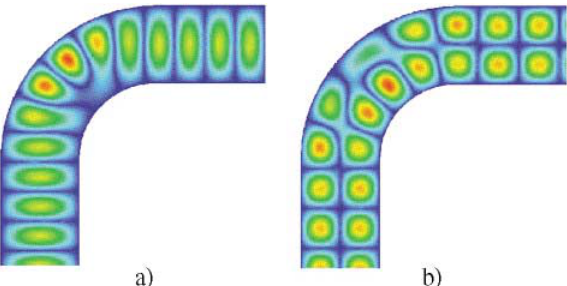
FIG. 5. (Color) Overmoded H-plane bend in a 1.442 in. wave- guide with simulated electric field plots illustrating (a) a TE 10 mode transmission and (b) a TE 20 mode transmission.